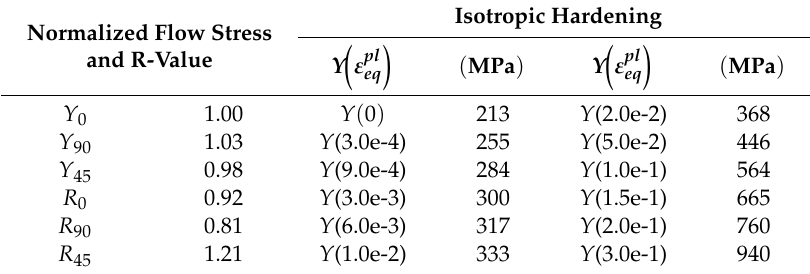
Table 2. Normalized flow stresses, R-values and plastic flow curve calculated from the uniaxial tensile test data. Nine specimens were tested for each cutting